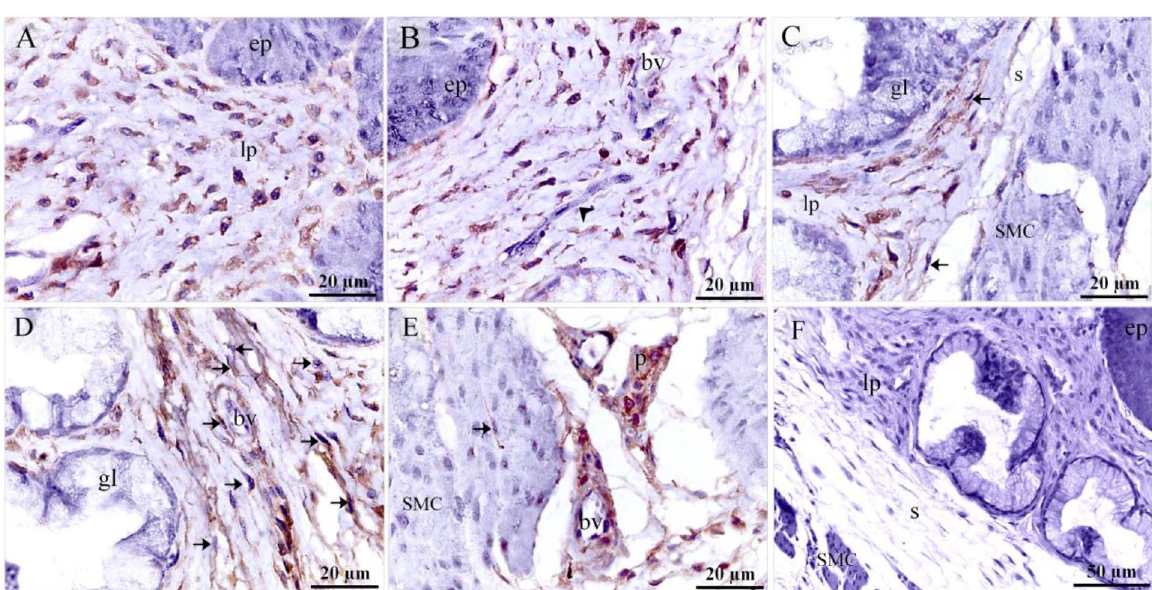
Figure 14. Immunohistochemical staining of the esophagus at day 15 using VEGF.Immunostained paraffin sections for VEGF. ( A ) Interstitial cells in the lamina propria (lp) were VEGF positive. Note the epithelium (ep). ( B ) Sprouting endothelial cells (arrowhead) were VEGF-postive. ( C ) Interstitial cells in the lamina propria (lp) were VEGF positive. VEGF-positive TC (arrow) was distinguished by their telopodes. Note gland (gl), submucosa (s), muscle (m). ( D ) Lamina propria (lp) rich in TCs (arrows). Note gland (gl), blood vessel (bv). ( E ) Perivascular tissue (p) was VEGF-positive. Note blood vessel (bv), muscle (m). VEGF-positive TC (arrow) was distinguished by their telopodes. ( F ) Negative control for VEGF immunostaining. Note epithelium (ep), lamina propria (lp), serosa (s), muscular layer